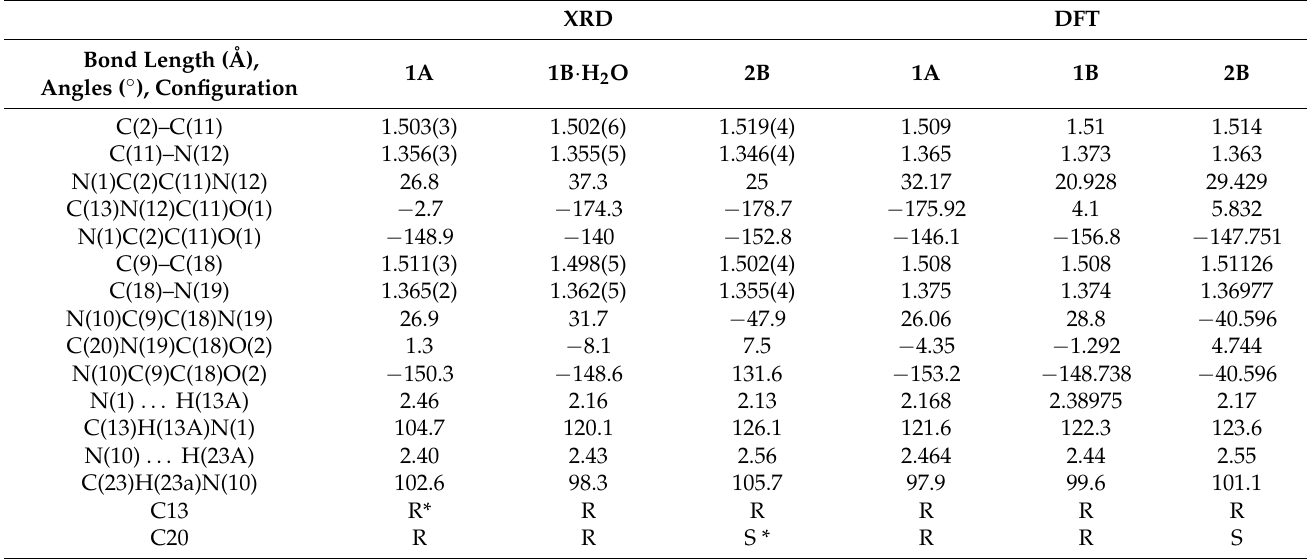
Table 1. Structural parameters of ligands 1 and 2 according to XRD and DFT data. XRD DFT